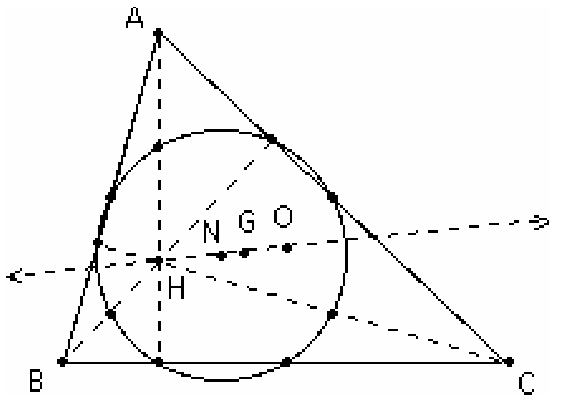
Figure 6. Nine-point circle & Euler line